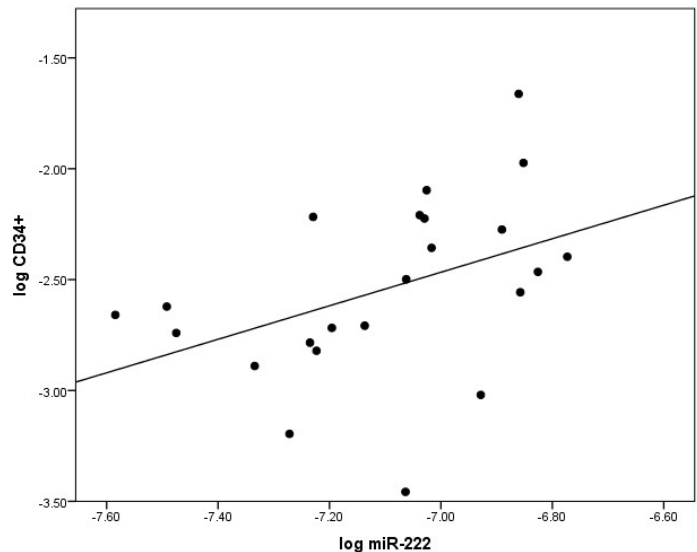
Figure 3. The significant correlation between levels of circulating miR‐222 (logmiR222) and CD34 + cells (log CD34 + ) at baseline. CD34 + were analyzed by flow cytometry. The relationship was demonstrated by Pearson correlation.